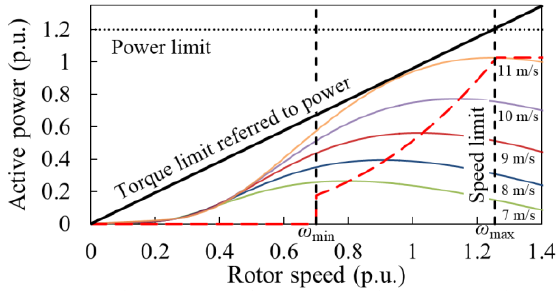
Figure 2. Input–output power characteristics of a DFIG.